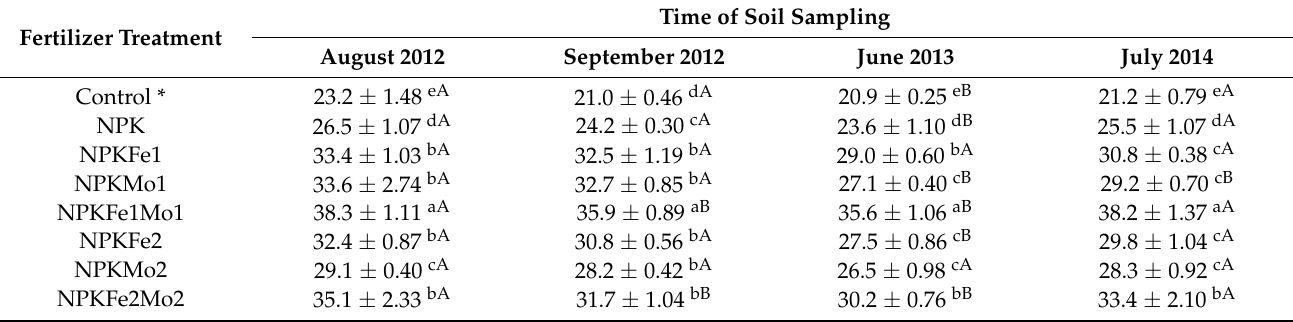
Table 5. Dehydrogenases activity in soil (in cm 3 H 2 h − 1 kg − 1